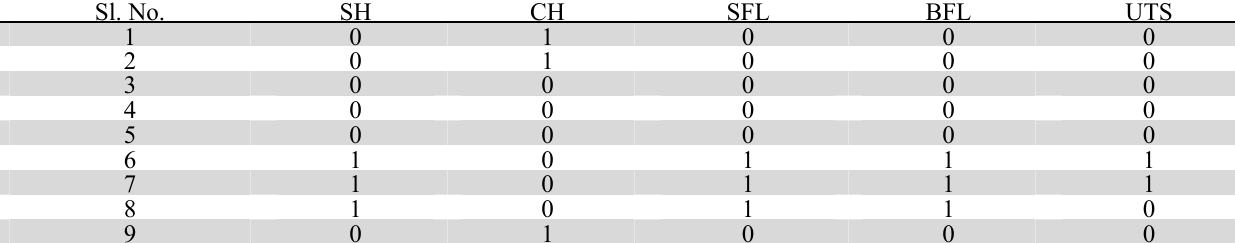
Incidence matrix ( B 6 ) at slicing parameter θ 6 = 0.60 for example 1 Sl. No.